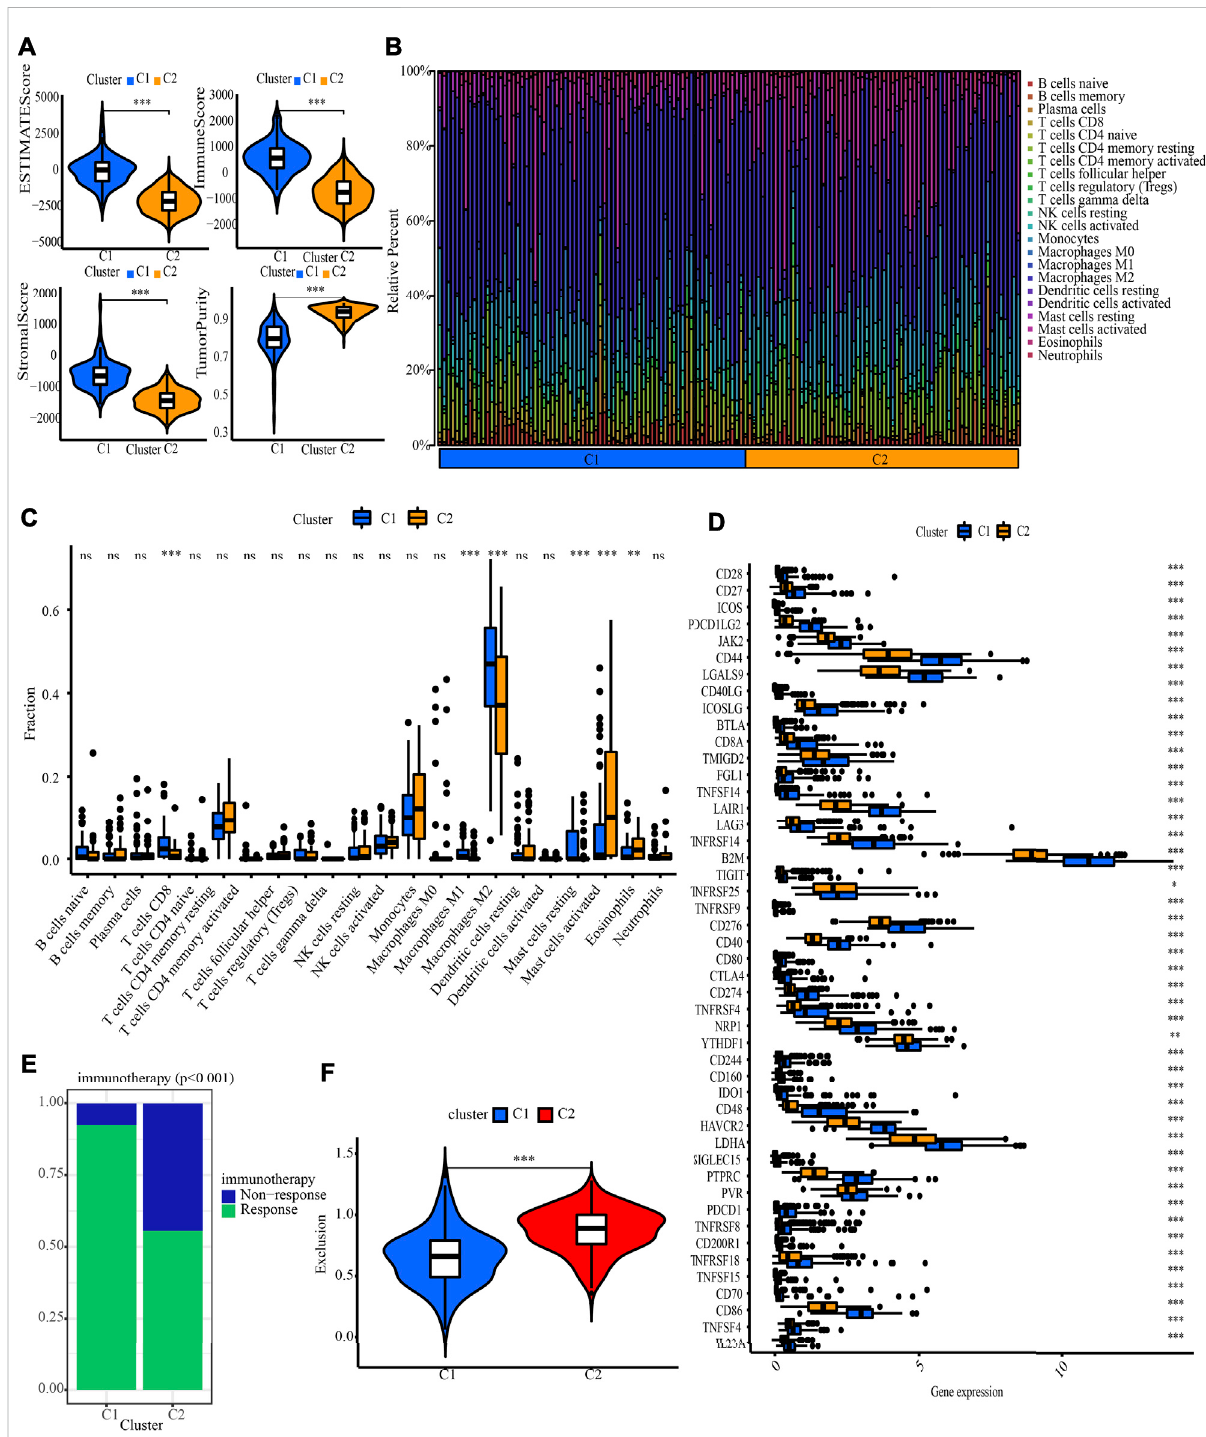
FIGURE 5 SystematicanalysisofTMEscores,immunecellin fi ltrationandimmunotherapyresponsepredictionintwomolecularsubtypes. (A) Comparison of TME components. (B) The proportion of 22 subsets of tumour-in fi ltrating immune cells in distinct subtypes. (C) Discrepancy analysis of tumour in fi ltrating immune cells in distinct subtypes (D) Differential expression analysis of 47 immune checkpoints genes between two molecular subtypes. (E) The discrepancy of immunotherapy response in two subgroups. (F) Immunotherapy response prediction in two